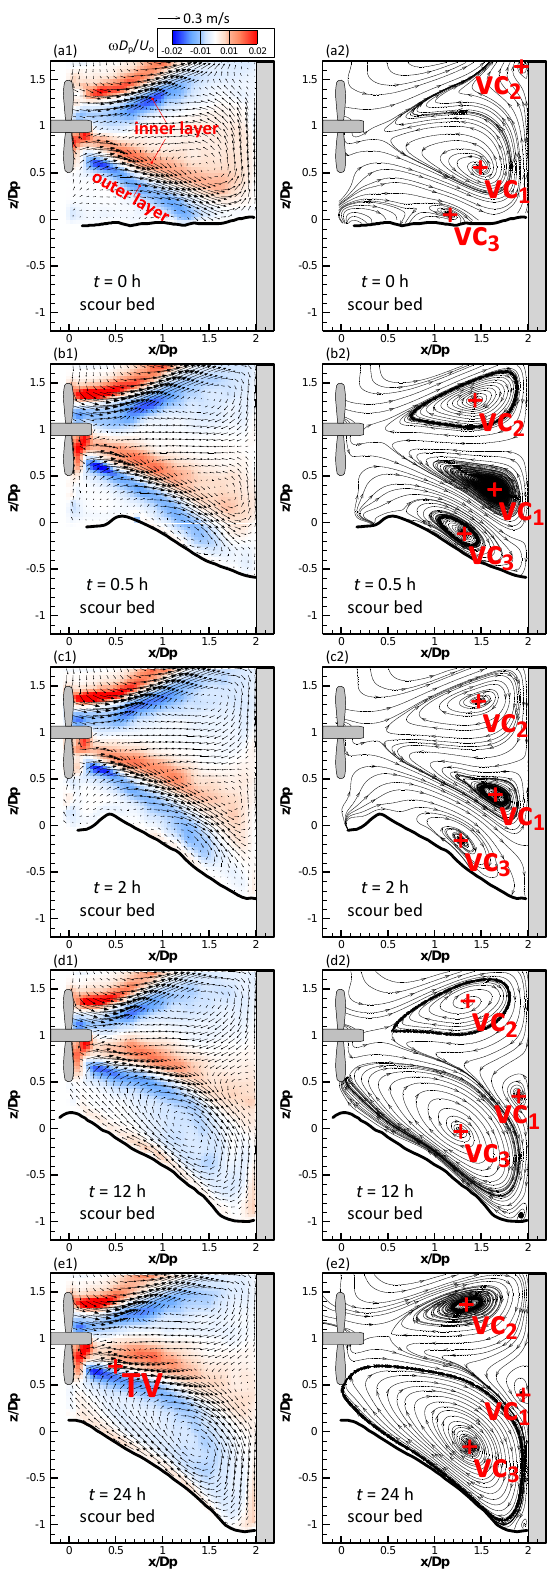
Figure 5. Temporal development of flow patterns within developing scour hole at X w = 2 D p : ( a1 , a2 ) t = 0 h; ( b1 , b2 ) t = 0.5 h; ( c1 , c2 ) t = 2 h; ( d1 , d2 ) t = 12 h; ( e1 , e2 ) t = 24 h.